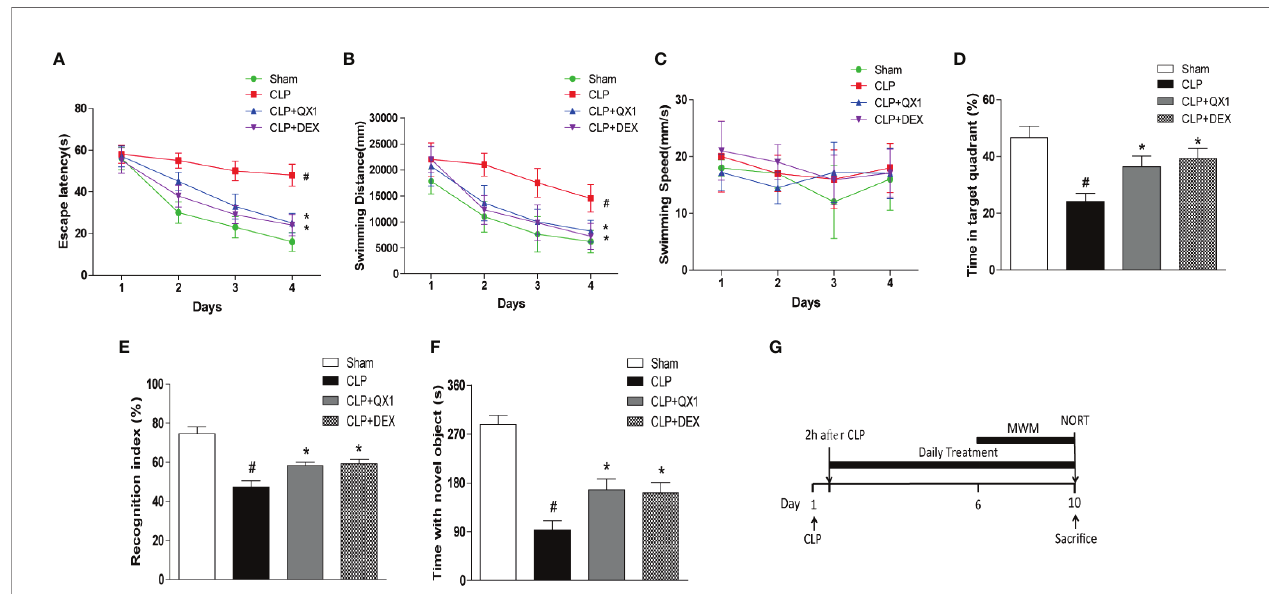
FIGURE 3 | QX1 formula ameliorates cognitive de fi cits in septic mice. Mice were randomized divided into sham, CLP, CLP treated with QX1 formula, and CLP treated with DEX groups. Mice were treated with QX1 formula (2 g/kg) or DEX (1 mg/kg) beginning at 2 h after CLP surgery. DEX was used as a positive control. In the Morris water maze test, (A) Escape latency, (B) swimming distance, (C) swimming speed, and (D) the percentage of time spent in the target quadrant on the fi fth day are presented respectively. (E) Recognition index, and (F) time spend with novel object in the novel object recognition task were presented respectively. Data were shown as mean ± SD (n=8-12 per group). (G) The fl ow chart of Morris water maze test and novel object recognition task. # p < 0.05 vs. sham, * p < 0.05 vs. CLP, For Morris water maze test, two-way ANOVA; for novel object recognition task, one-way